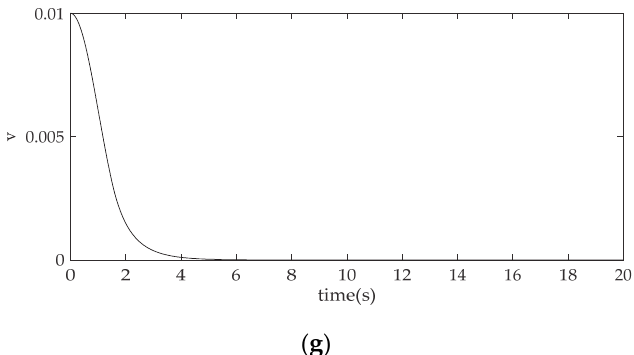
Figure 10. ( a ) Speed response of adaptive robust control in the presence of external disturbances; ( b ) Tracking error of adaptive robust control in the presence of external disturbances; ( c – g ) Parameter adaptation of adaptive robust control in the presence of external disturbances.